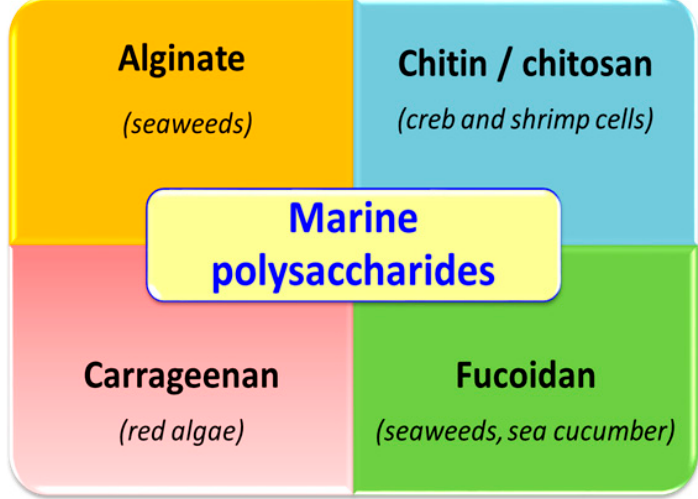
Figure 1. Marine polysaccharides of interest for cosmeceutical, nutraceutical and pharmacological applications. The marine organism sources are also reported.